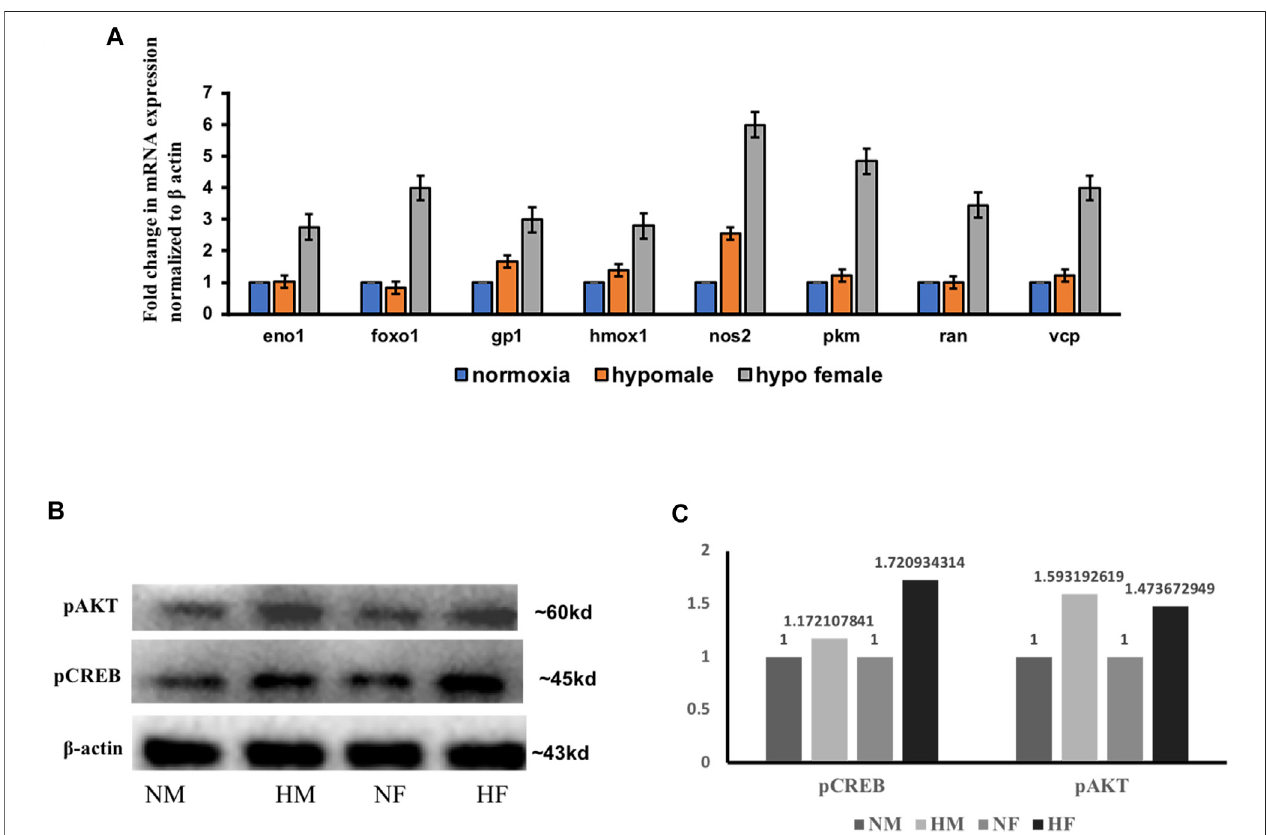
FIGURE4| Validationoffewregulatorytargetmolecules.GraphshowingmRNAexpressionofeno1,foxo1,gp1,hmox1,nos2,pkm,ran,andvcp (A) Thedataare expressedasthemean ± SEM,( n (cid:1) 6pooledbrains).ImmunoblotshowingexpressionofpCREBandpAKTinmaleandfemalebrain (B) ,Densitometryforcomparisonof protein expression in HM vs. NM and HF vs. NF (C) .